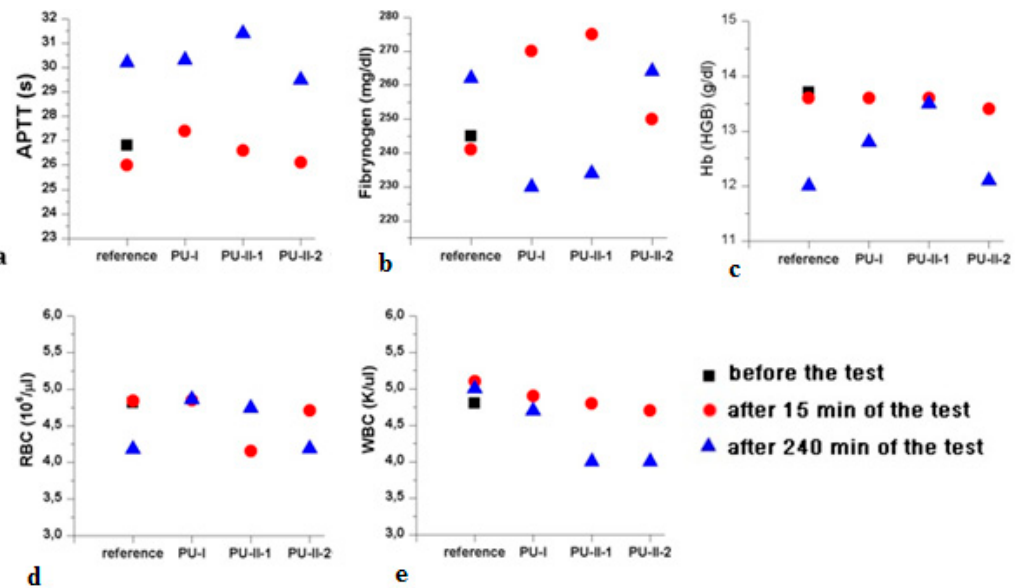
Figure 9. Selected results of PVA-crosslinked and non-crosslinked PURs hemocompatibility. APTT ( a ); Fibrynogen ( b ); Hb ( c ); RBC ( d ); and WBC ( e ).